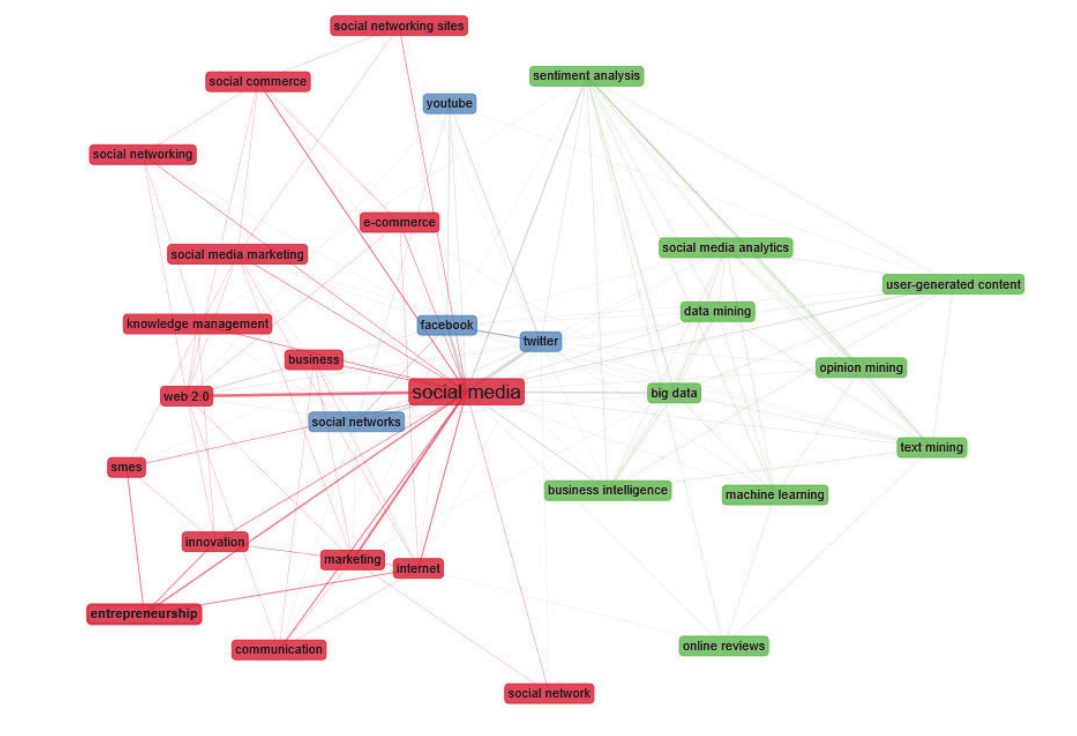
Fig. 7. Co-occurrence network